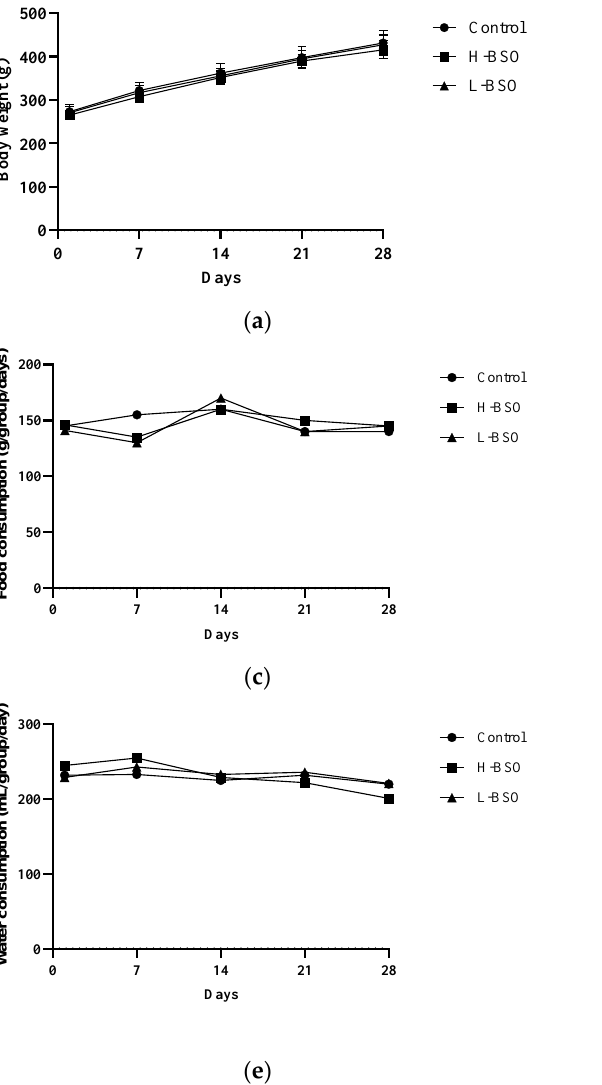
Figure 3. Body weight, food consumption, and water consumption of rats (( a , c , e ): male; ( b , d , f ): female) after administration of H-BSO and L-BSO for 28 days. Values are expressed as ± standard error of the mean; one-way analysis of variance followed by Tukey test ( n = 6 animals/group). Differences between groups were considered to be significant at p < 0.05.